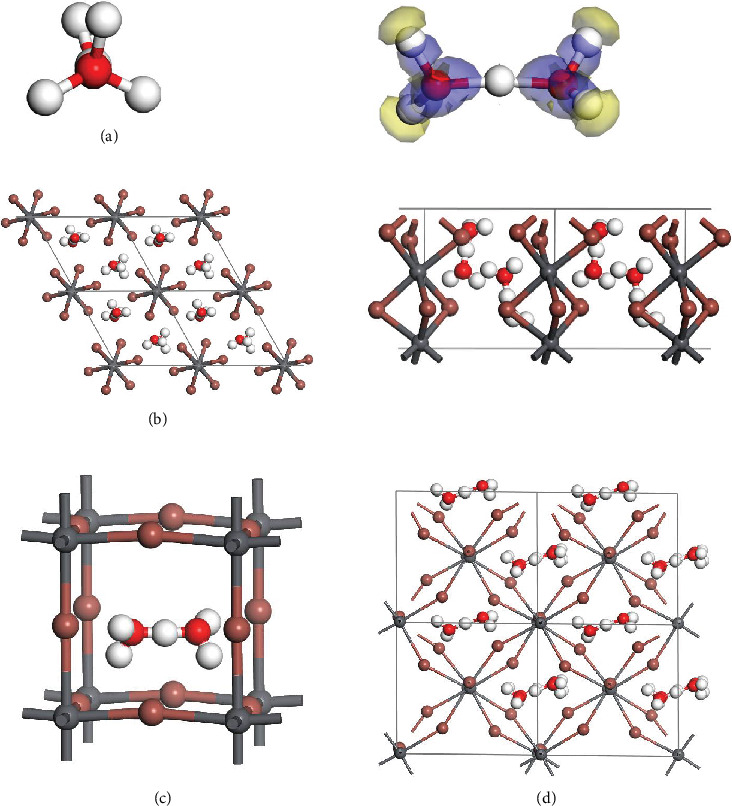
(a) Structure and computed electron deformation density (side view) of cation H5O2+. Structure of the (b) orthorhombic, (c) cubic, and (d) tetragonal phases of (H5O2)PbI3.